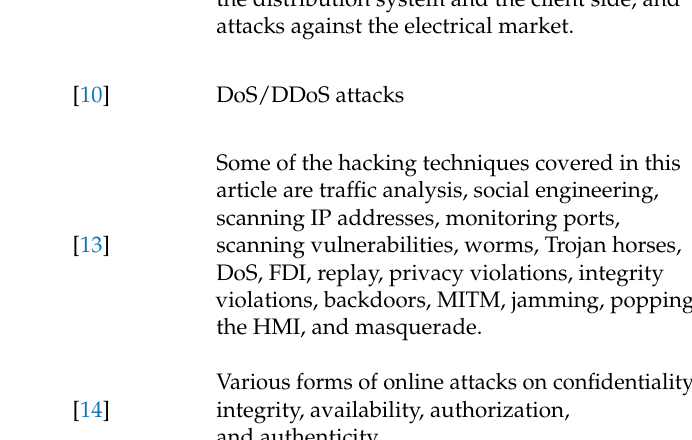
Table 1. Existing Surveys Related to the Cyber-security of Smart grids.